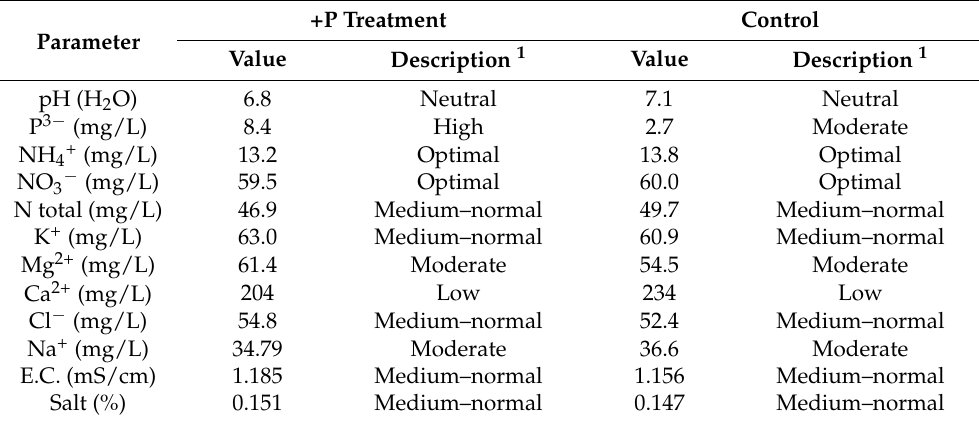
Table 2. Mean nutrient contents of the growth substrates in the treatment boxes. The +P treatment had elevated phosphorus content. The control had no added